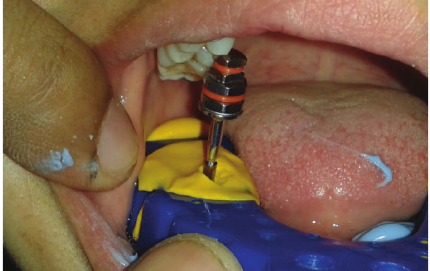
Figure 13: Transfer coping attached.